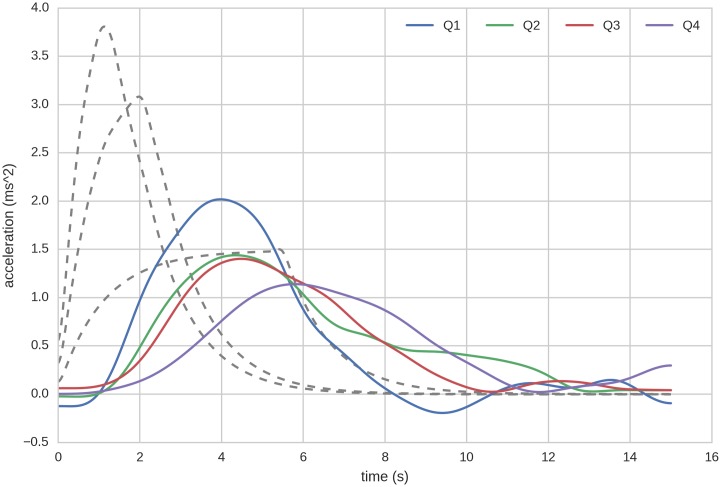
Average acceleration of the following vehicle in speed transition 50km/h to 80km/h.The coloured curves represent quartiles based on time headway at the start of the transitio. The dotted lines are the three different acceleration profiles of the lead vehicle. For this transition, the quartiles (in seconds) correspond to Q1 < 1.98, Q2 = {1.98, 2.90}, Q3 = {2.90, 4.12}, Q4 > 4.12. All curves have been smoothed by a Gaussian filter, with sigma corresponding to 0.5s. For other transitions see supplementary figures.